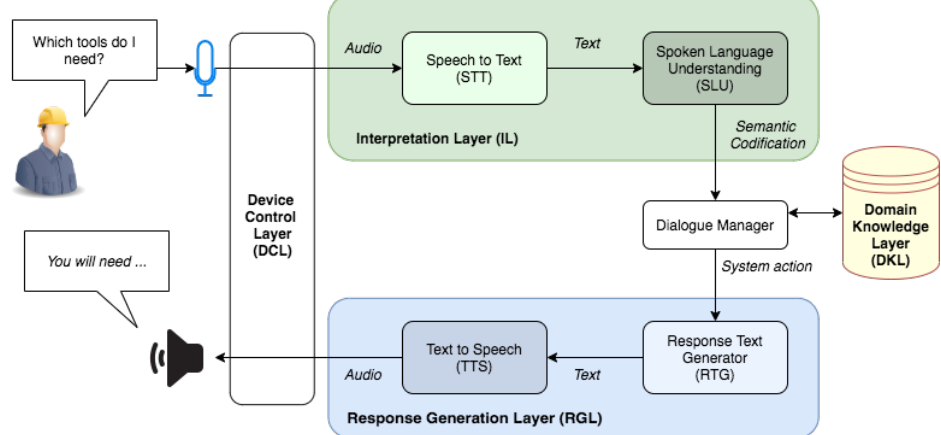
Figure 1. Traditional dialogue system